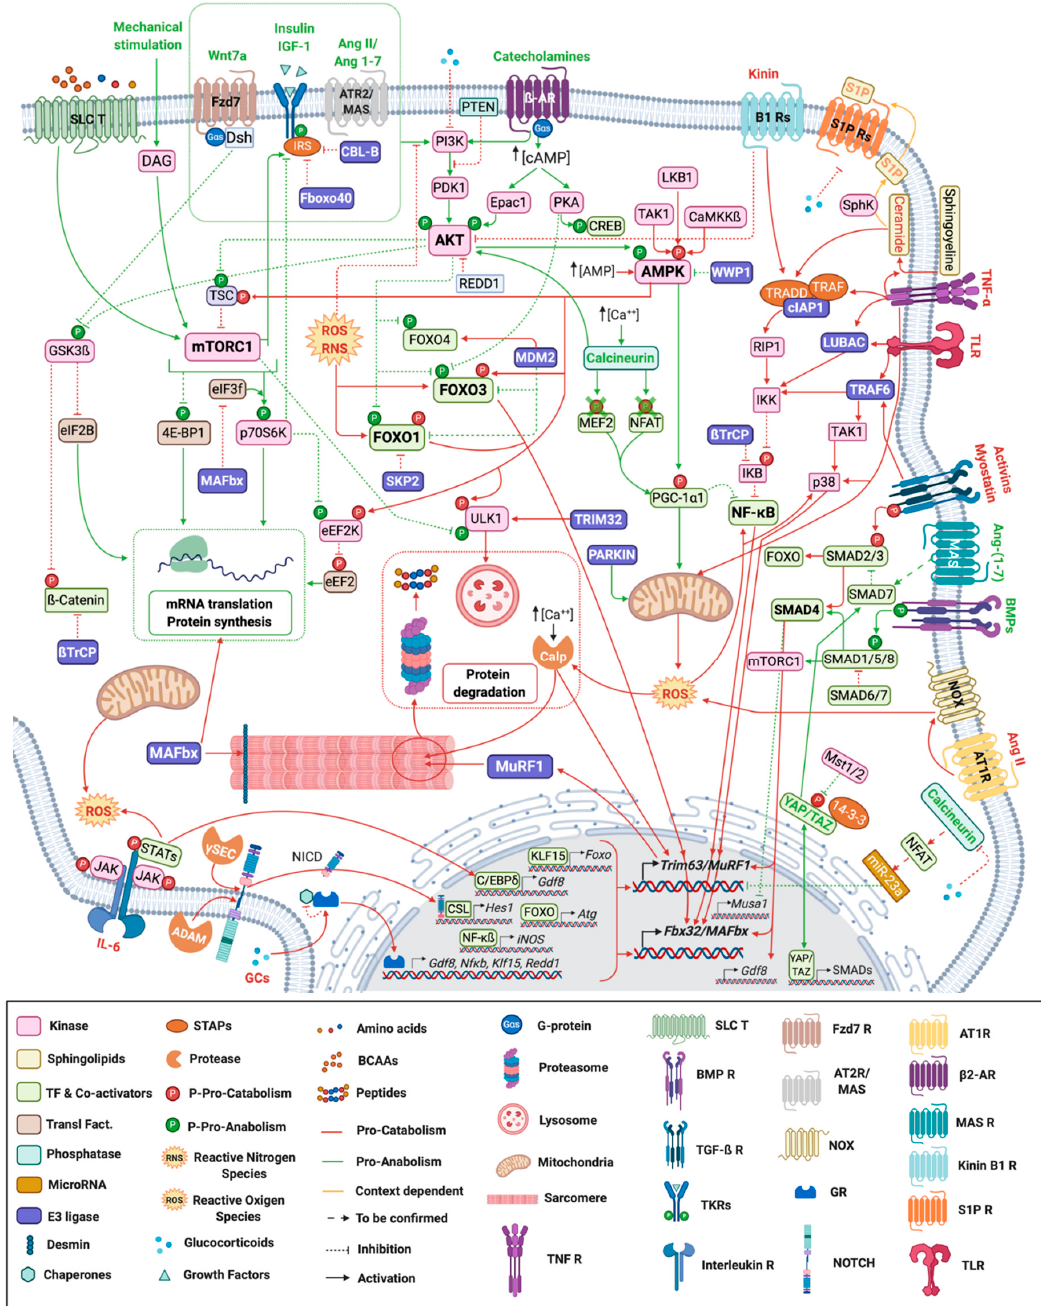
Figure 1. Signaling pathways regulating skeletal muscle mass and function. Myofiber representation of the different signaling pathways controlling skeletal muscle mass and function during atrophy conditions. Ligands and arrows (both with head or perpendicular line) in green denote those signaling pathways and interactions with an anabolic effect whereas the red ones represent catabolic signaling. Orange ligands and arrows stand for pathways with a dual role (context-dependent). ß2-AR: ß-2 Adrenergic Receptor; 𝛾 -sec: 𝛾 -secretase; Ang: Angiotensin; AT1R: Angiotensin II Type 1 Receptor; AT2R: Angiotensin II Type 2 Receptor; BCAAs: Branched-chain amino acids; BMP R: Bone Morphogenetic Receptor; Calp: Calpain; CSL: CBF1, Suppressor of Hairless, Lag-1; Dsh: Dishevelled; Fzd: Frizzled; GR: Glucocorticoid Receptor; IL-6: Interleukin-6; NCID: Notch Intracellular domain; NOX: NADPH oxidase activator; P: Phosphorylation; S1P: Sphingosine-1-phosphate; SLC T: Solute Carrier Transporter; STAPs: Signal Transducing Adaptor Proteins; TF: Transcription Factors; TGF-ß R: Transforming Growth Factor ß Receptor; TKR: Tyrosine-protein Kinase Receptor; TLR: Toll-like Receptor; TNF R: Tumor Necrosis Factor Receptor; Transl. Fact.: Translational Factors.